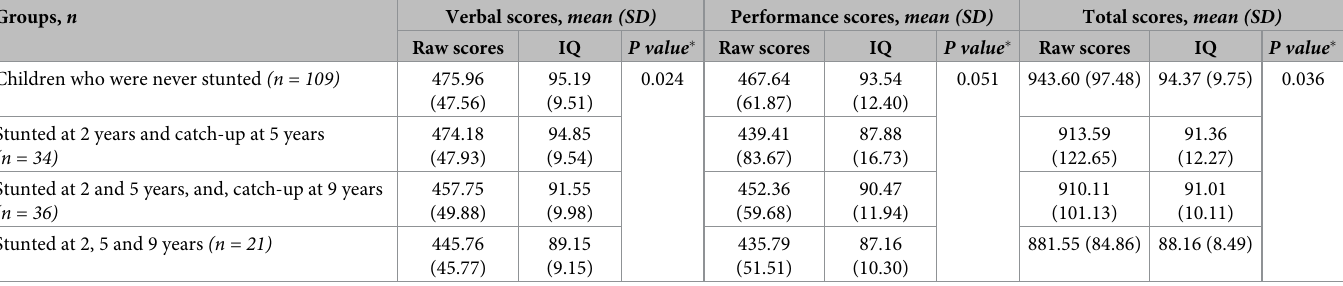
Table 3. Distribution of verbal, performance and total cognition raw scores, and IQ at 9 years in children who were stunted at various time points of follow-up in MAL-ED cohort (N = 200 # ). Groups,